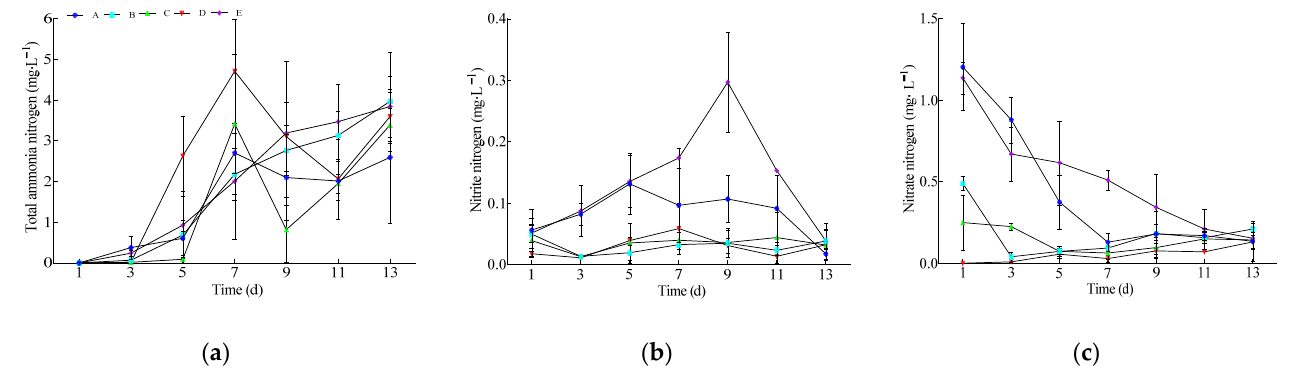
Figure 2. The variation in ( a ) total ammonia nitrogen (TAN), ( b ) nitrite nitrogen (NO 2 − -N) and ( c ) nitrate nitrogen (NO 3 − -N) of five treatments.